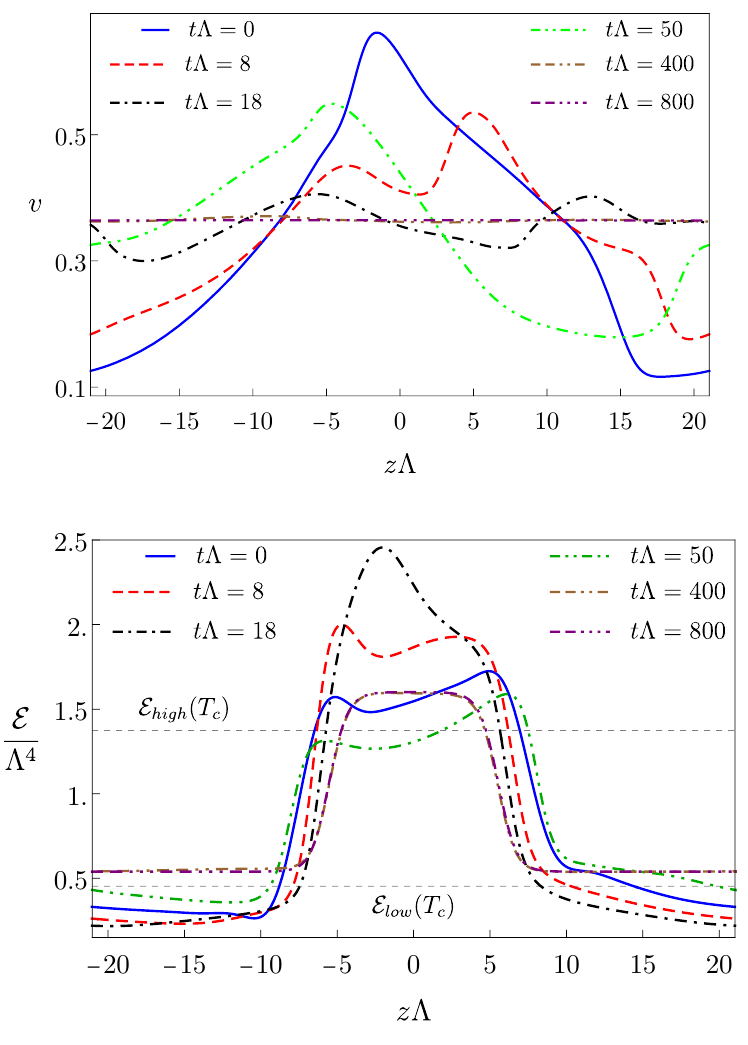
Figure 3 . Time evolution of the fluid velocity (top) and of the energy density profile (bottom) for a domain in motion. To facilitate the comparison, each profile has been shifted by a constant amount to match the domain midpoint with z Λ = 0 . The maximum of the fluid velocity at t Λ = 0 is v max = 0 . 66